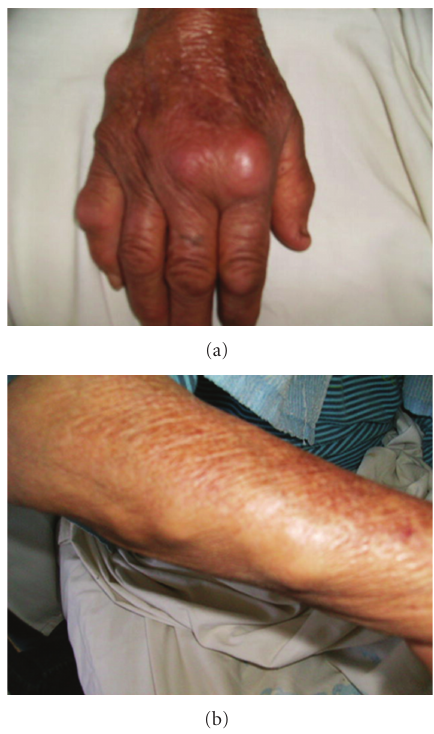
Figure 1: Multiple mobile painful nodules on irregular surface of the dorsal face of the right hand as well as the front homolateral